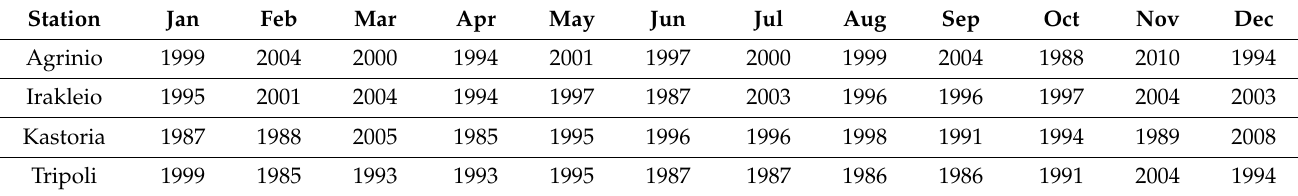
Table 1. The Helenic National Meteorological Service (HNMS) stations of Agrinio, Irakleio, Kastoria, and Tripoli with their typical meteorological months (TMMs) selected from different years in the time period of 1985-2014. Station